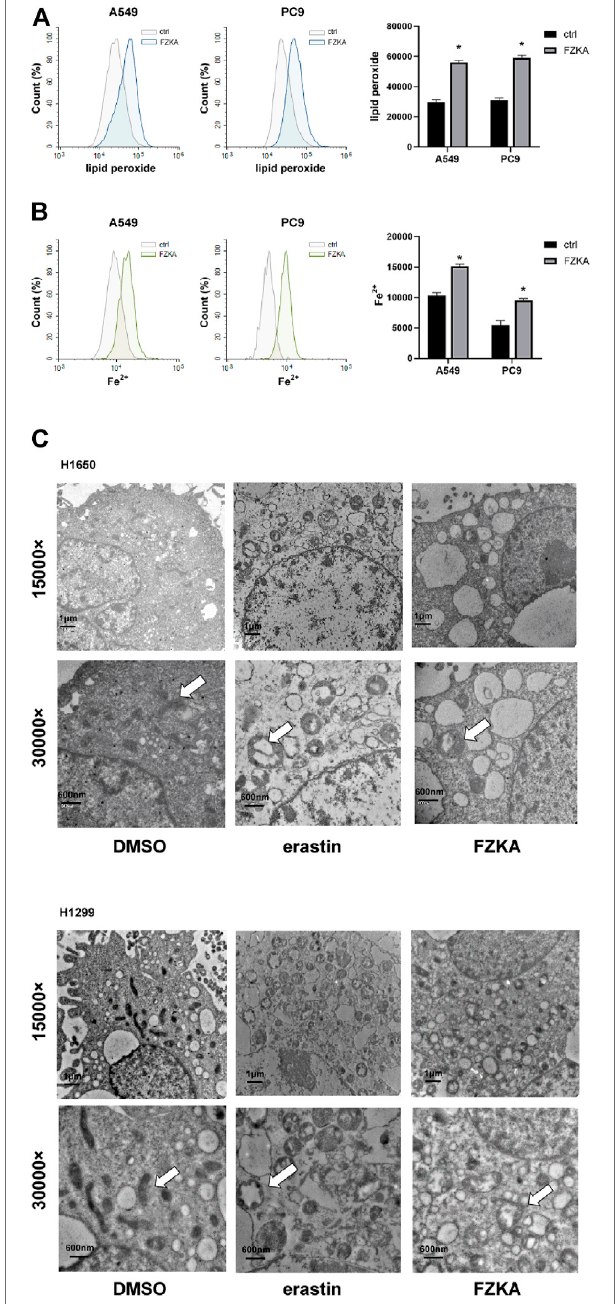
FIGURE2| FZKA induced ferroptosis inNSCLCcellsbyFCM and TEM. (A,B) ,CellswerestainedwithC11-BODIPY(10 μ M)orFerroOrange(1 μ M)for 30 min, the level of lipid peroxidation and Fe 2+ Ions was detected by fl ow cytometry, * p < 0.05. (C) , Transmission electron microscopy of H1650 and H1299 cells treated with DMSO (10 h), erastin (ferroptosis inducer, 10 µM, 10 h), FZKA (1 mg/ml, 10 h). The mitochondria appeared to be changed including swollen, cristae loss and mitochondira vacuolization in H1650 and H1299 cells. Scale bar represents 1 µM and 600 nm.